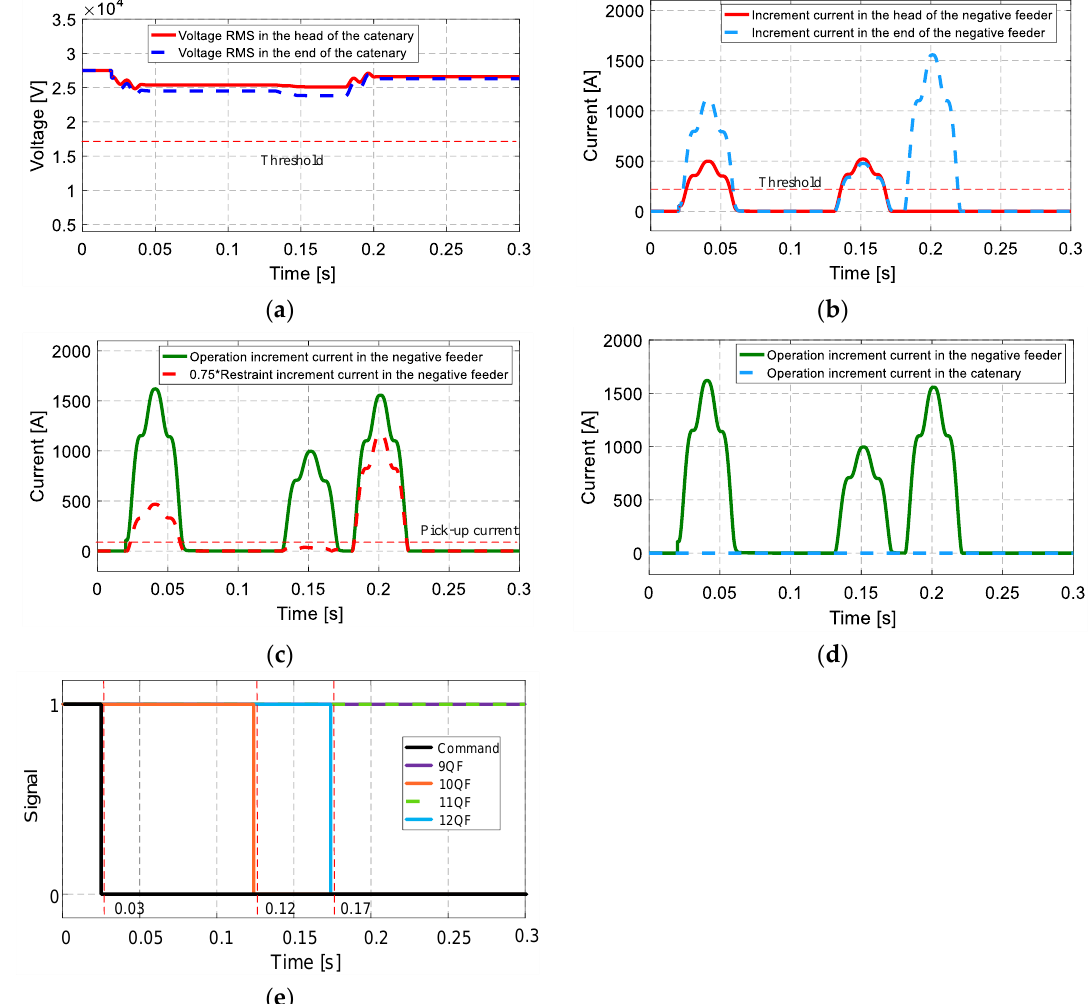
Figure 16. Catenary voltage RMS, increment current, operation and restraint increment current, and signals in NF-G short circuit at the AT subsection 3: ( a ) Catenary voltage RMS in TS and ATS; ( b ) increment current in the negative feeder; ( c ) operational and restraint incremental current in the negative feeder; ( d ) operation increment current in the negative feeder and catenary; and ( e ) signal of the command and the circuit breakers.